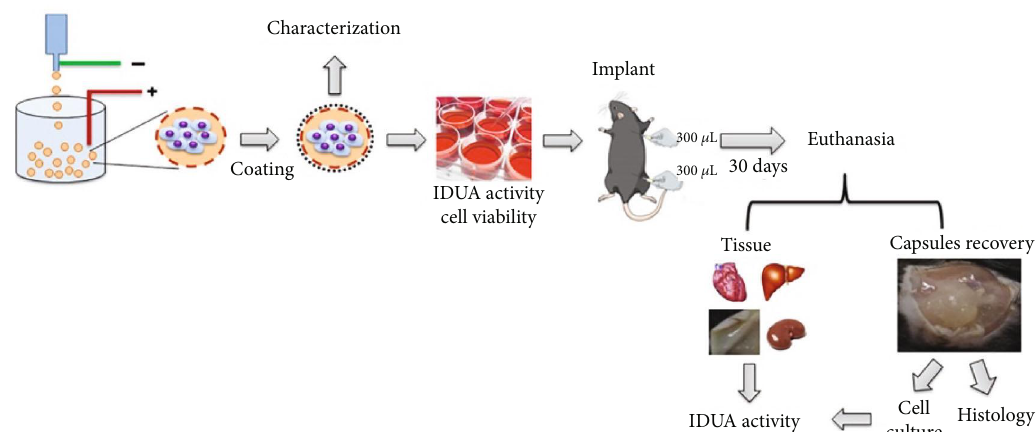
Figure 21: Schematic illustration of the fabrication of alginate microcapsules and in vivo and in vitro characterization [68].